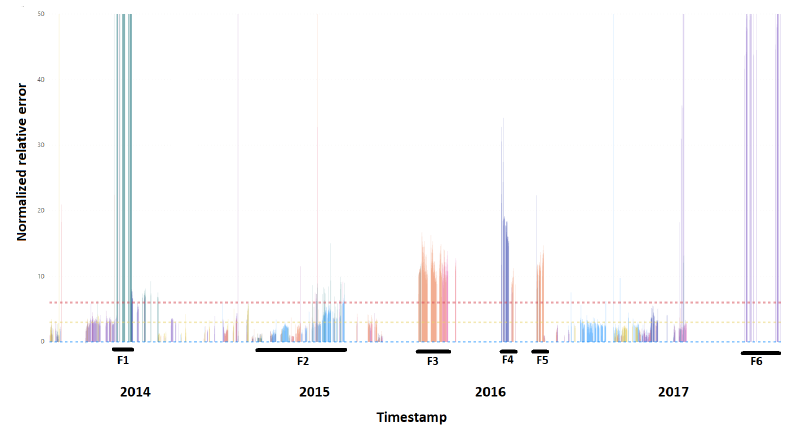
Figure 10. Normalized relative error ( NRE ) with colored sources of events and failures that